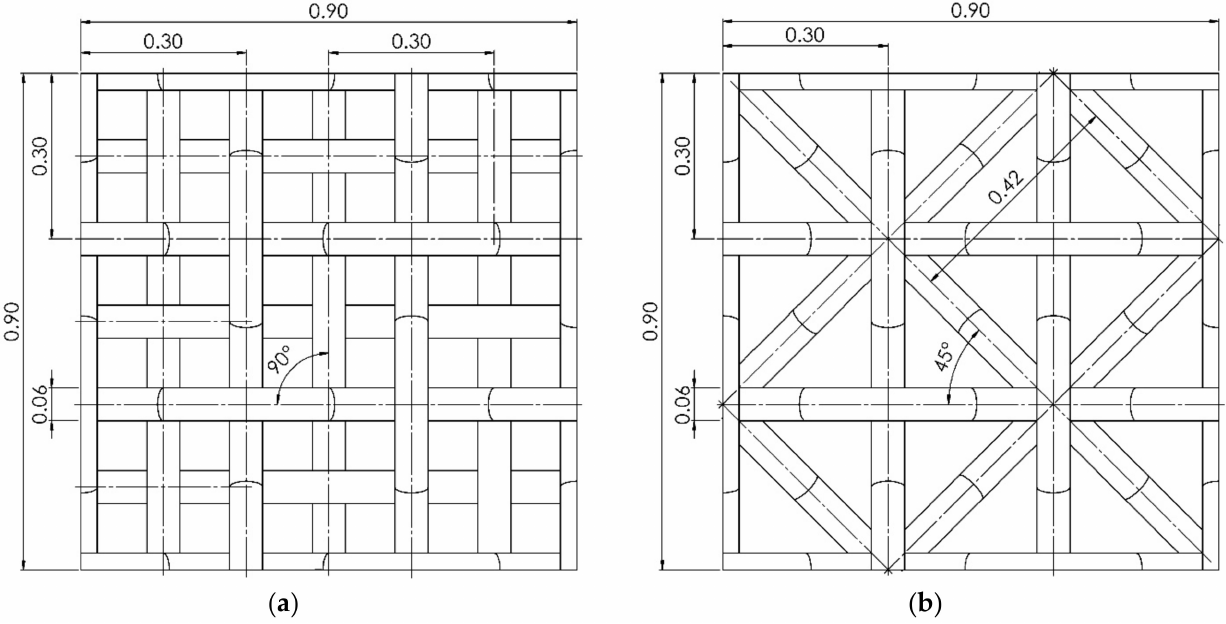
Figure 1. Comparison of dimensions of basic ( a ) and novel ( b ) geometries.